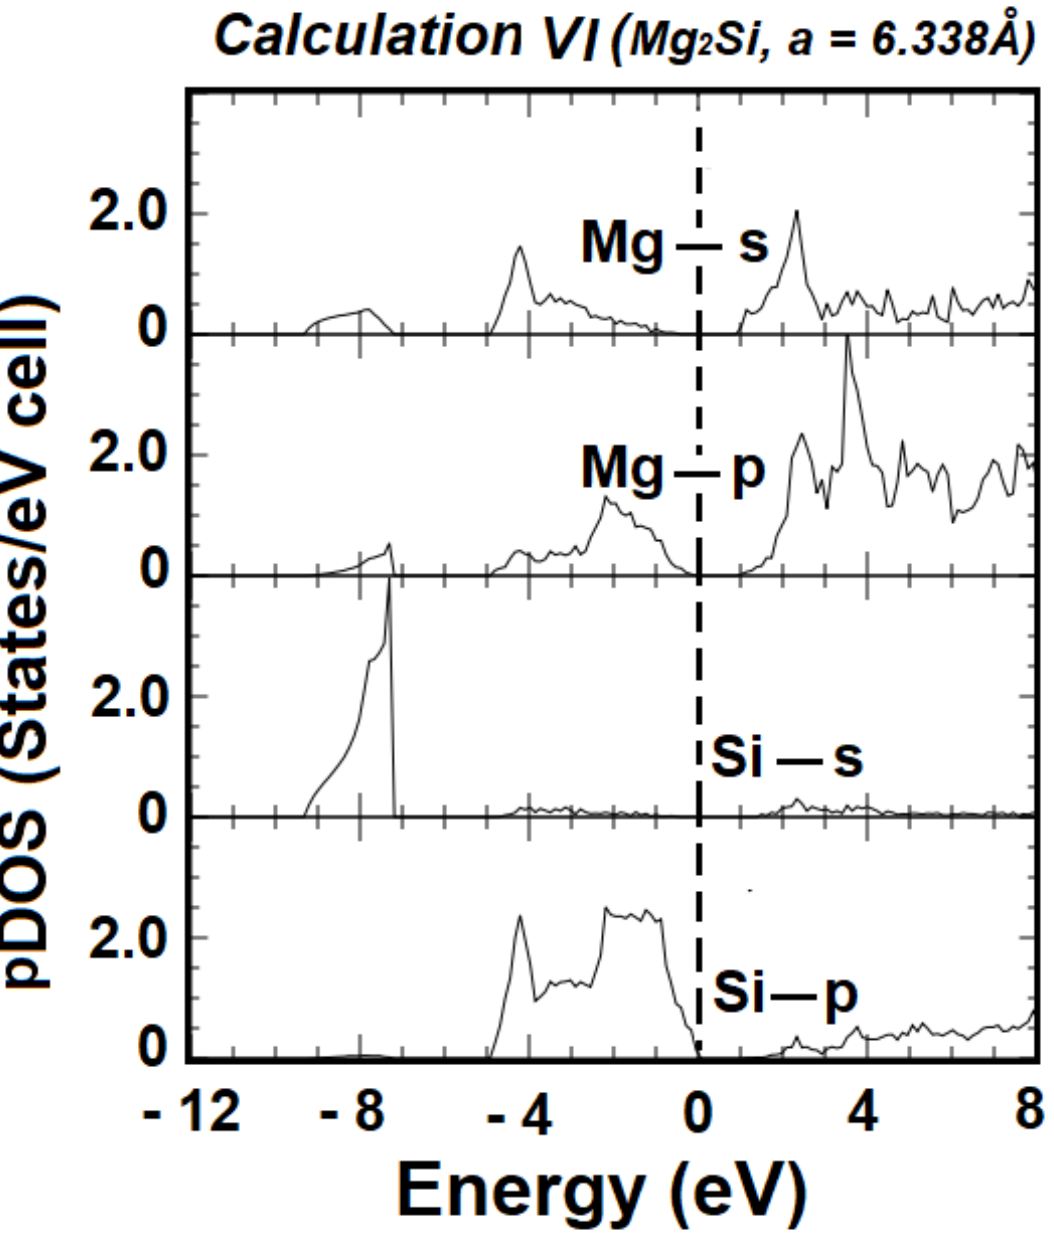
Figure 5. Partial densities of states (pDOS) of Mg 2 Si, as derived from ground state band structure from Calculation VI. The vertical dashed line indicates the position of the Fermi level.